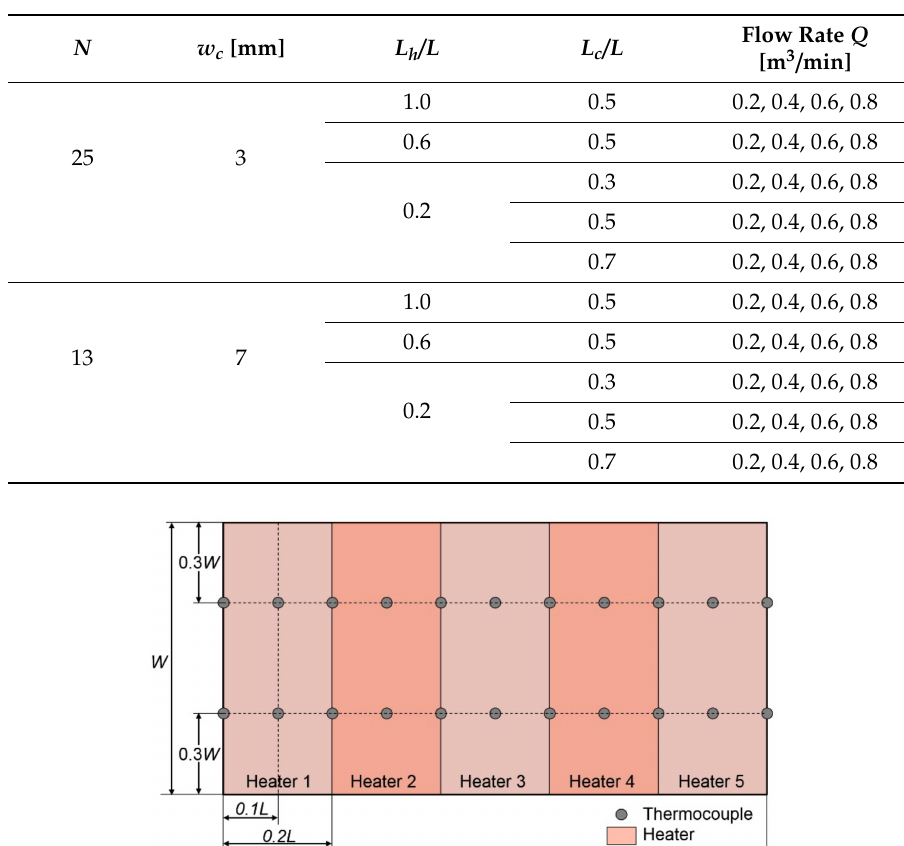
Table 1. Design parameters for the experiment.